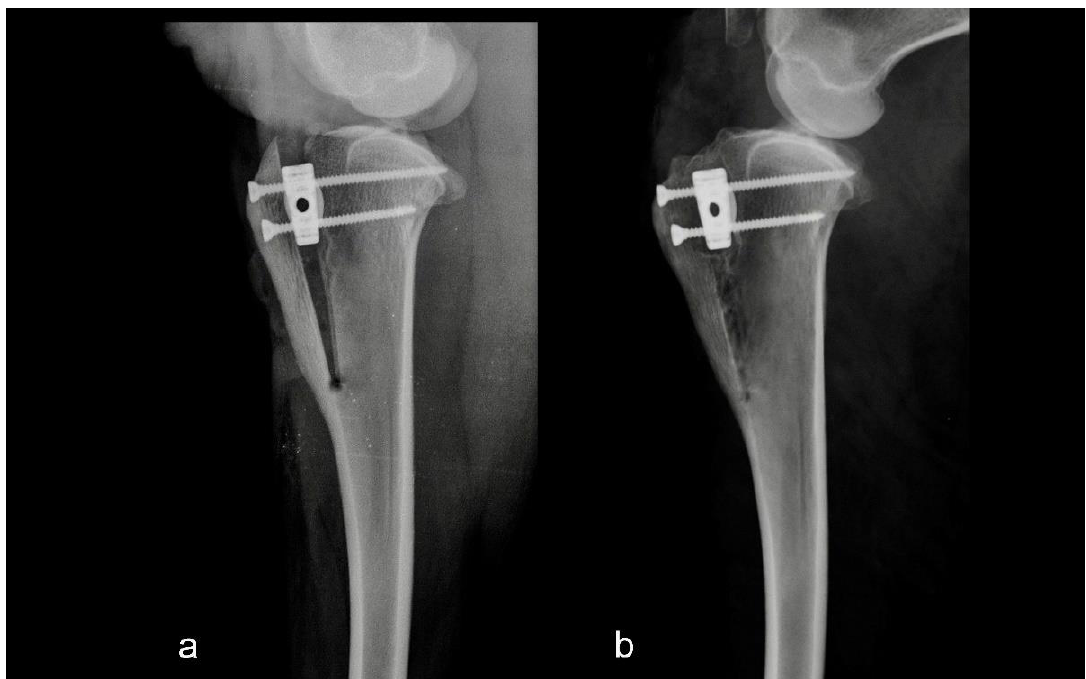
Figure 1. Mediolateral radiograph of the stifle in Group 1 immediately postoperatively ( a ) and at six months postoperatively ( b ). Osteotomy and tibial tuberosity advancement were performed as assumed preoperatively.